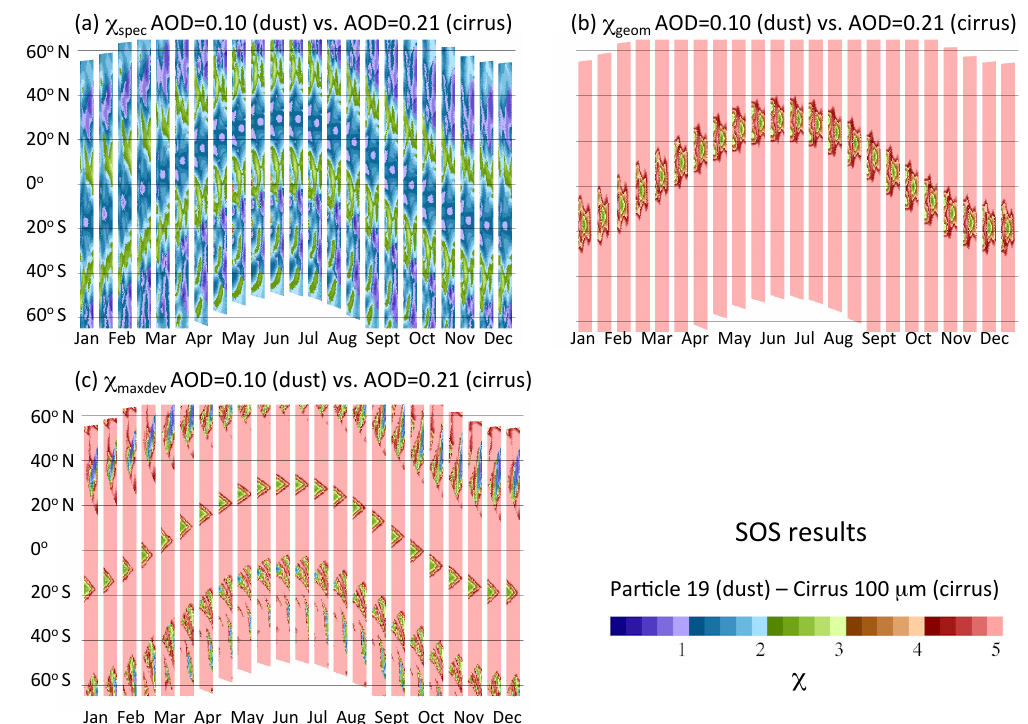
Fig. 18. Same as Fig. 17b but for three additional χ 2 metrics used by the MISR V22 Dark Water aerosol retrieval algorithm: (a) χ 2 spec , (b) χ 2 geom , and (c) χ 2 . These metrics emphasize different aspects of the MISR observing strategy, and different thresholds are employed maxdev for these metrics compared to χ 2 . The V22 thresholds are 3, 3, and 5, for “spec”, “geom”, and “maxdev”, abs